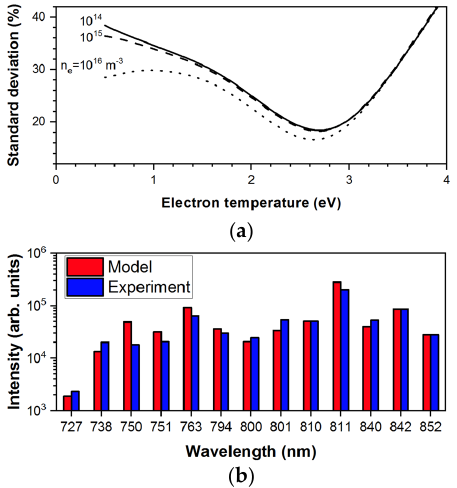
Figure 5. ( a ) Evolution of the percentage standard deviation as a function of the electron temper- ature for three electron number densities and a base pressure p 0 ~5 mTorr. ( b ) Agreement of the experimental and model emission line intensities for the optimal ( T e , n e )